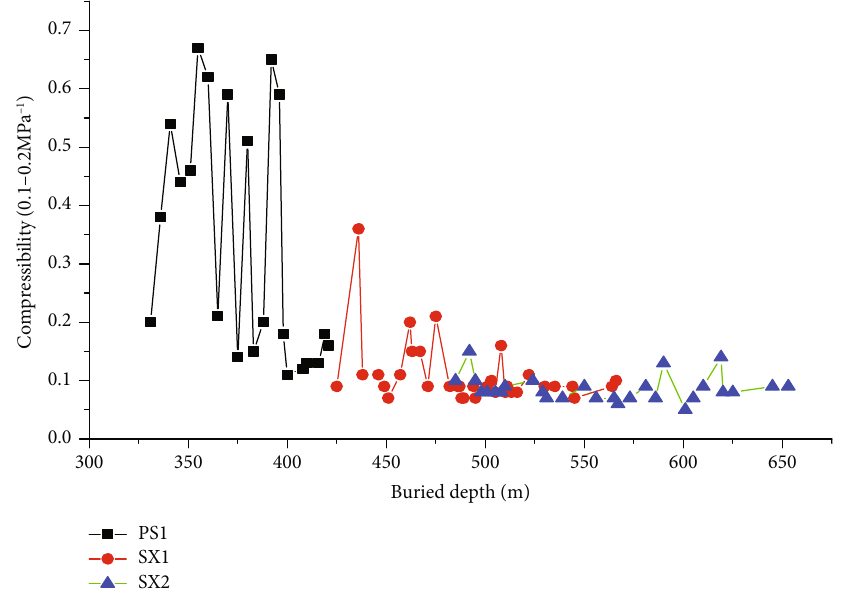
Figure 4: Clay compression coe ffi cient and burial depth curve.